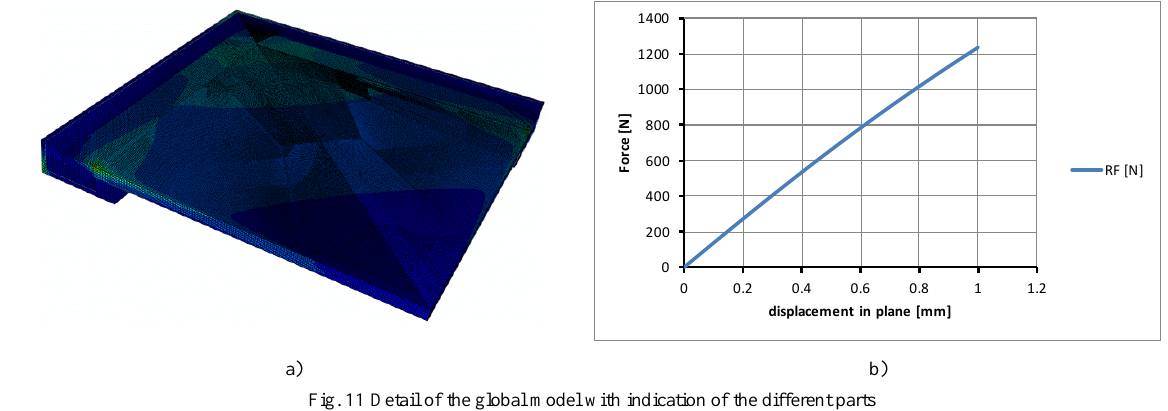
Fig. 11 Detail of the global model with indication of the different parts